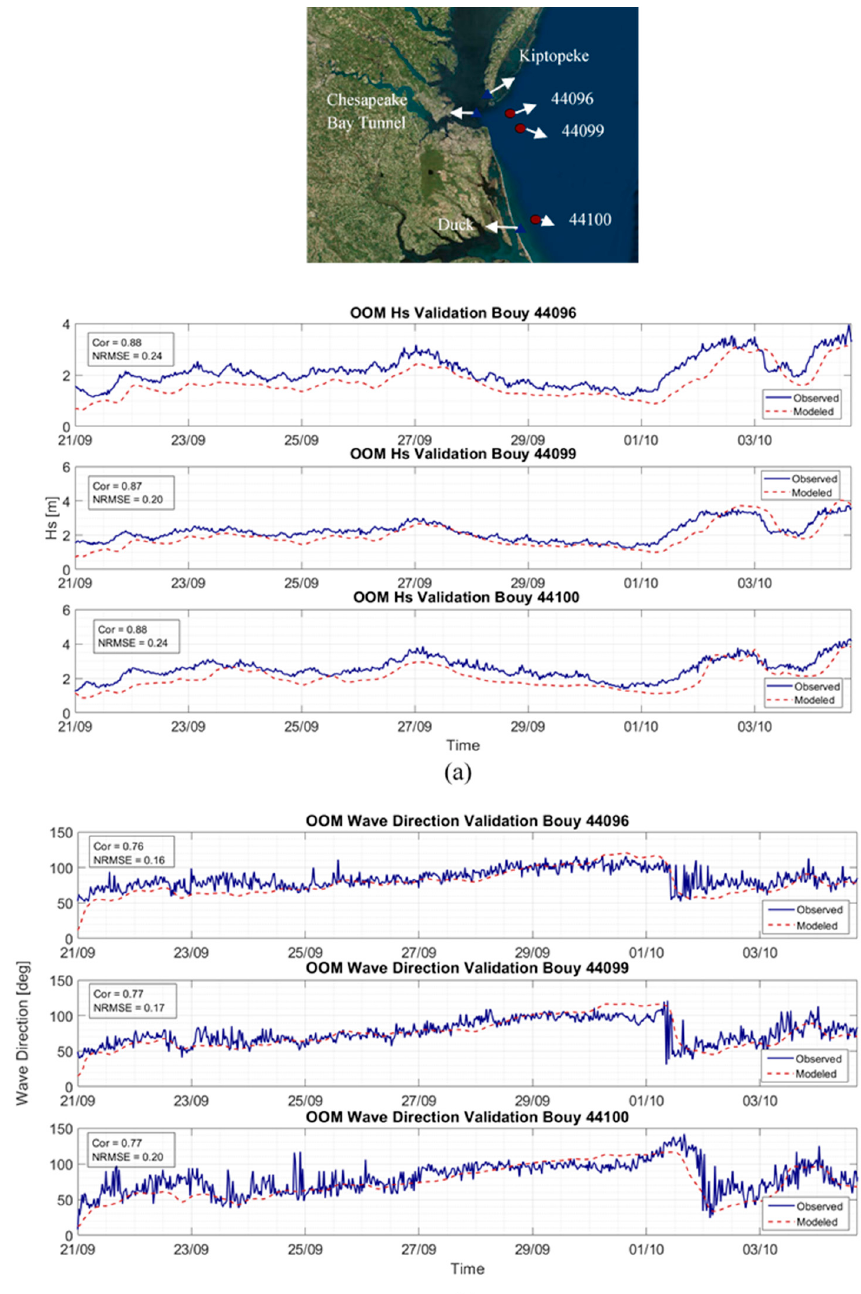
Figure 5. Comparison between the observed (blue) and model (red) results. The legend on the left indicates correlation coefficient (Cor) and normalized root mean square error (NRMSE): ( a ) Comparison between the significant wave heights ( Hs ); and ( b ) Comparison between the wave directions.